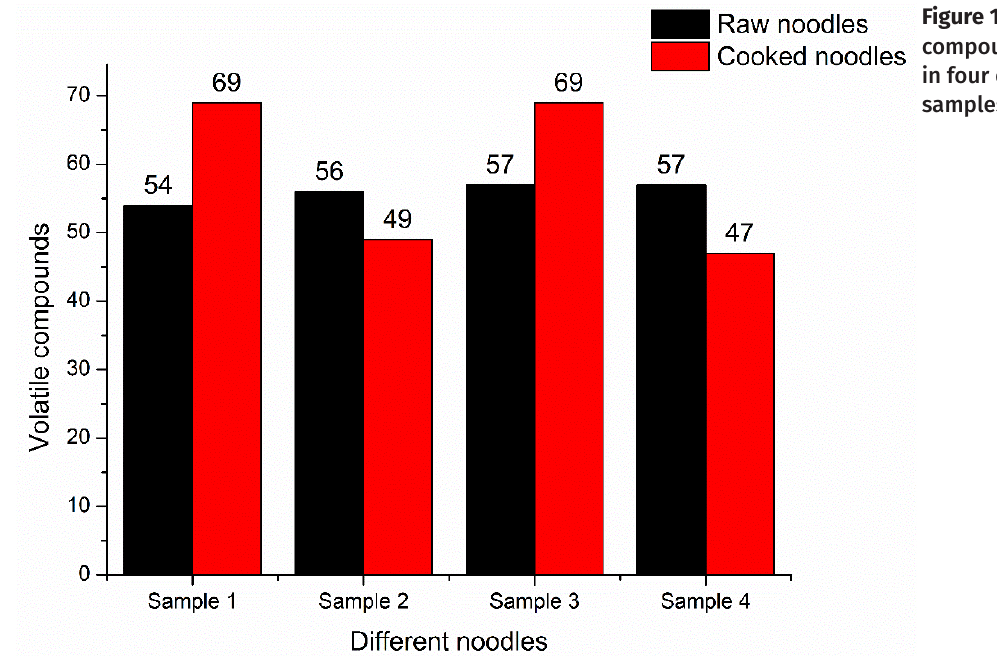
Figure 1. Sum of volatile compounds identified in four different noodle